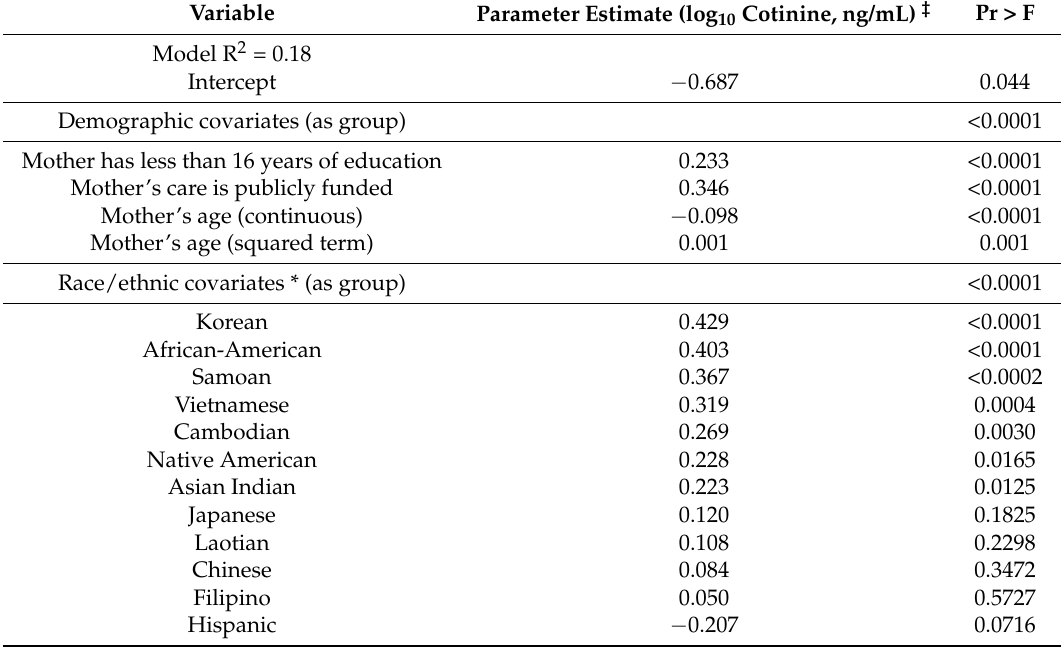
Table 4. Regression analysis of race/ethnicity and other demographic characteristics and environmental tobacco smoke (ETS) exposure (log 10 serum cotinine, ng/mL) among non-smoking * prenatal screening program enrollees; San Diego, Orange and Imperial counties (N = 2880) † . Variable Parameter Estimate (log 10 Cotinine, ng/mL) ‡ Pr > F Model R 2 = 0.18 − 0.687